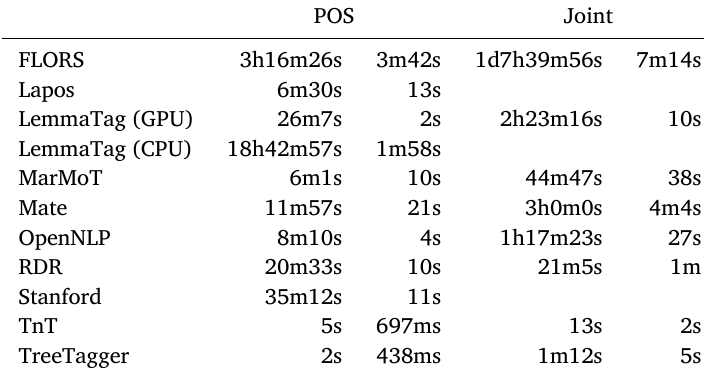
Table 26: Run-times for a partition of Tiger